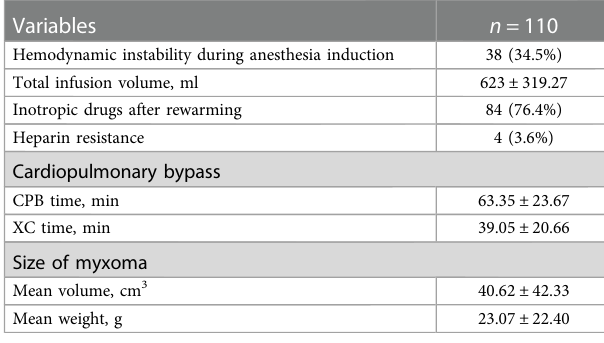
TABLE 3 Intraoperative